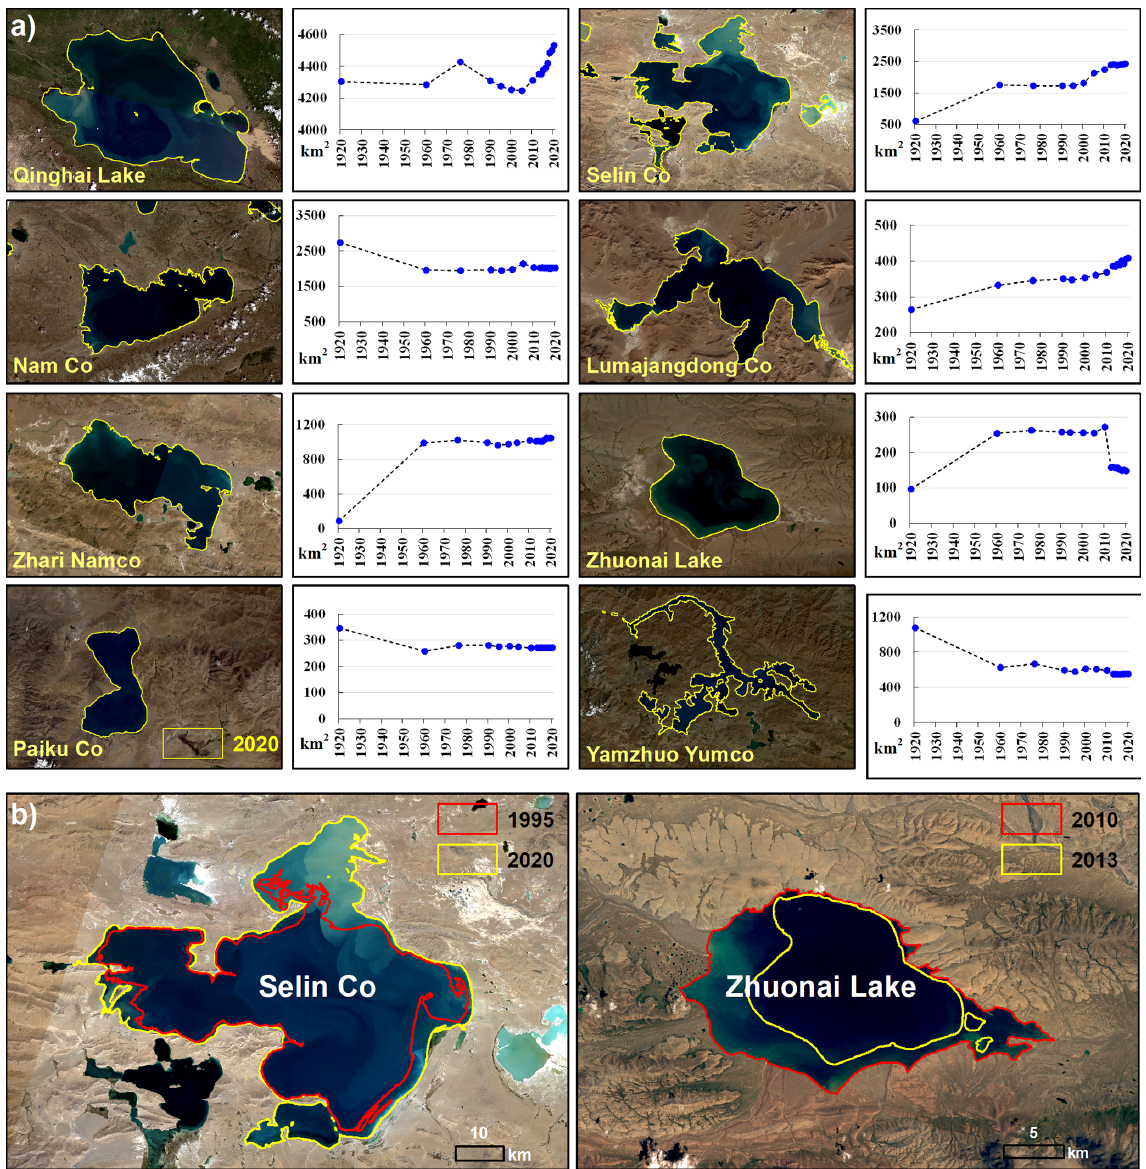
Figure 7. Examples showing the evolution of eight selected lakes from 1920 to 2020, with background of Landsat images (Bands 3, 2, 1 composite). (a) Time series of eight selected lake area from 1920 to 2020. (b) Images for Selin Co and Zhuonai Lake as examples of rapid lake expansion and rapid shrinkage, respectively. The locations of these lakes are shown in Fig.